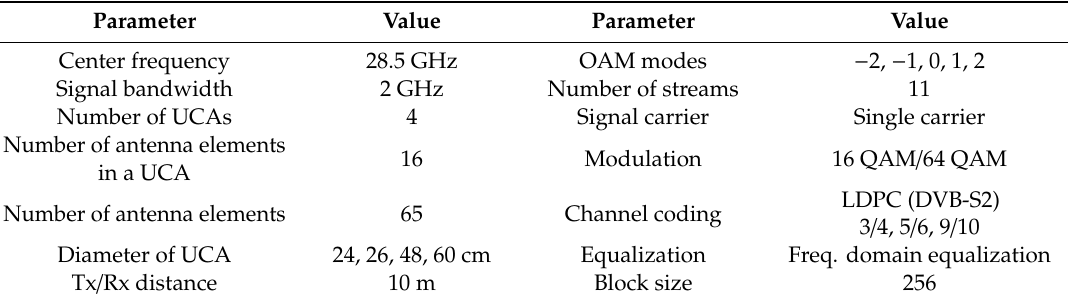
Figure 10. Experimental environment (OAM-MIMO multiplexing).